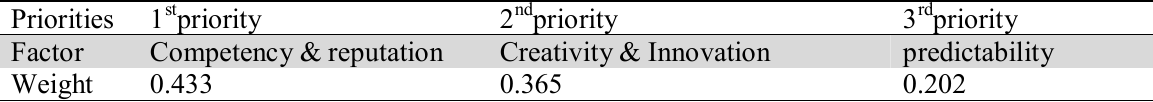
The results of ranking of website components Priorities